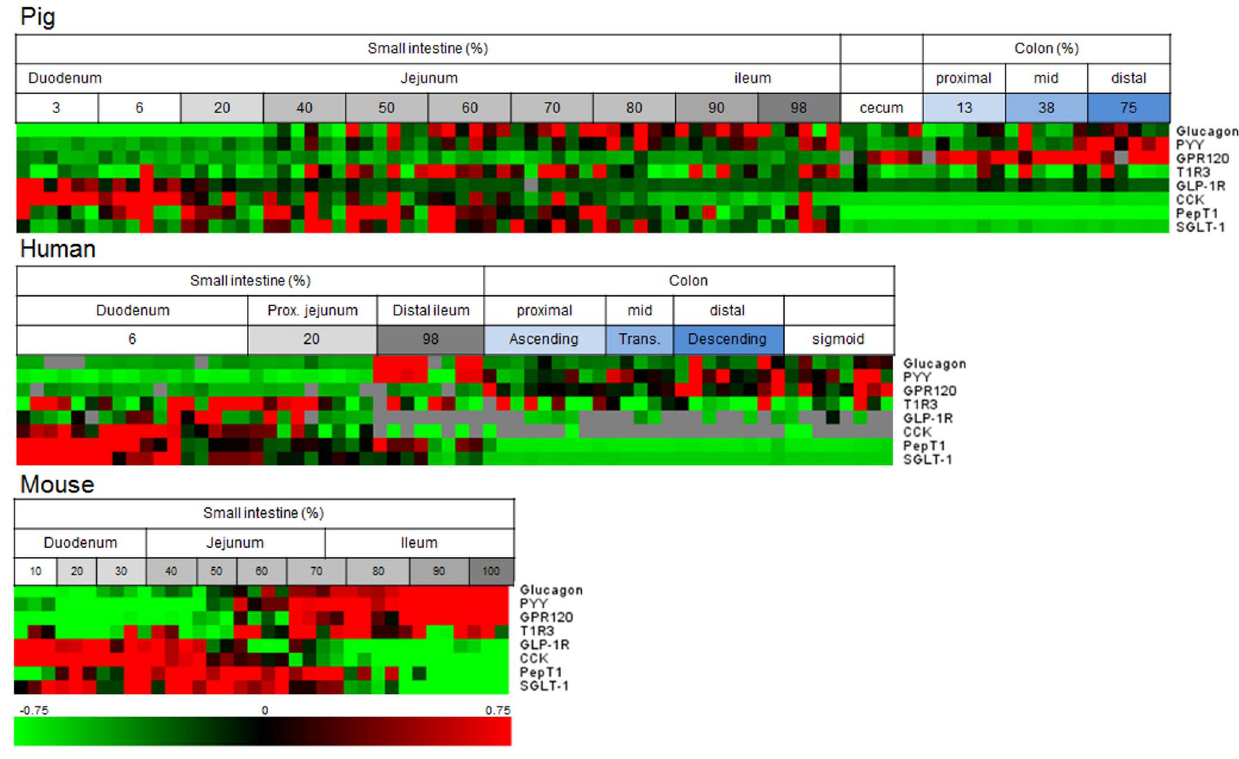
Figure 2. Heatmap of pig, human and murine gene expression results. Horizontally the individual samples of different parts of the intestine are aligned from proximal to distal and vertically the eight genes are shown. Green and red indicate low and high gene expression compared to average, respectively. Grey indicates samples that could not be analyzed/detected.